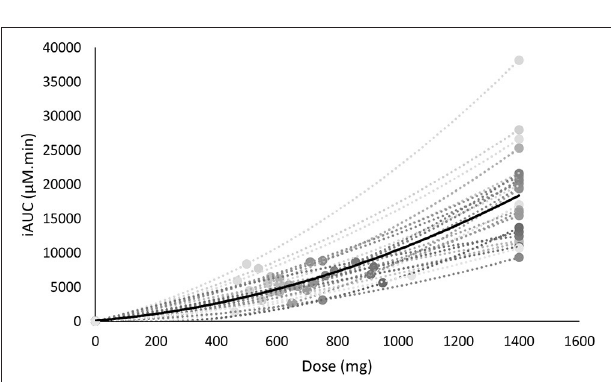
FIGURE 4 | The iAUC of β -alanine is non-linearly related with the supplemented dose. The mean is shown in black, whereas the individual values are shown in